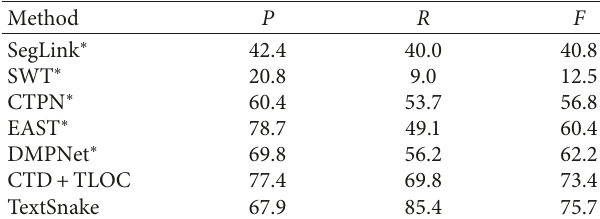
Table 9: SCUT ctw1500